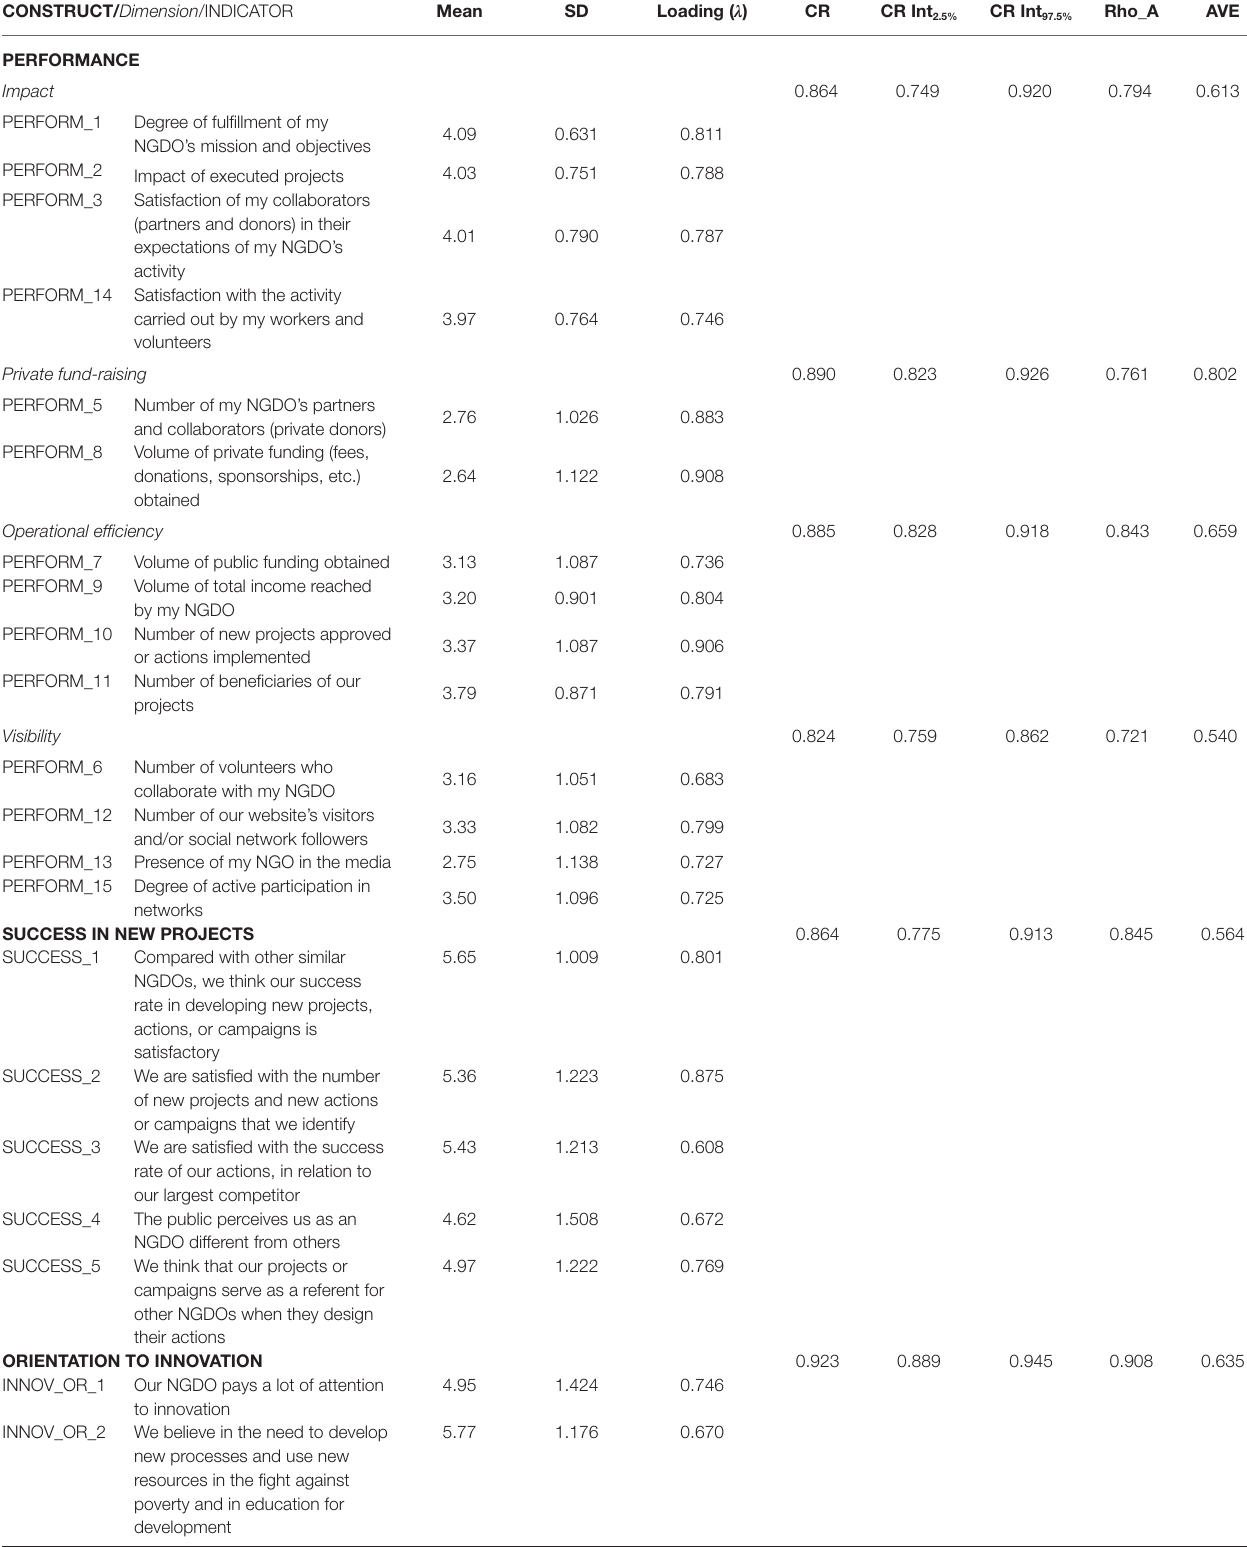
TABLE 6 | Validation indicators of the first-order model’s measurement instruments. CONSTRUCT/ Dimension /INDICATOR Mean SD Loading ( λ ) CR CR Int 2.5% CR Int 97.5% Rho_A AVE